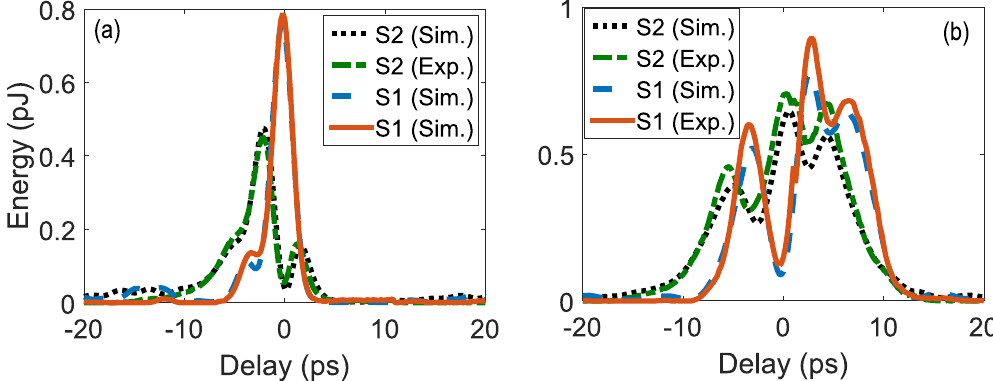
Figure 8. Selective conversion of spectrally identical pulses. The two signals are shown in Fig. 5. ( a ) compares the measured and simulated SF power for both signal modes when they are relatively delayed from the converting pump pulses whose phase and amplitude profiles are optimized for selective upconversion of Signal 1. ( b ) plots the same but with the pump optimized for Signal 2.